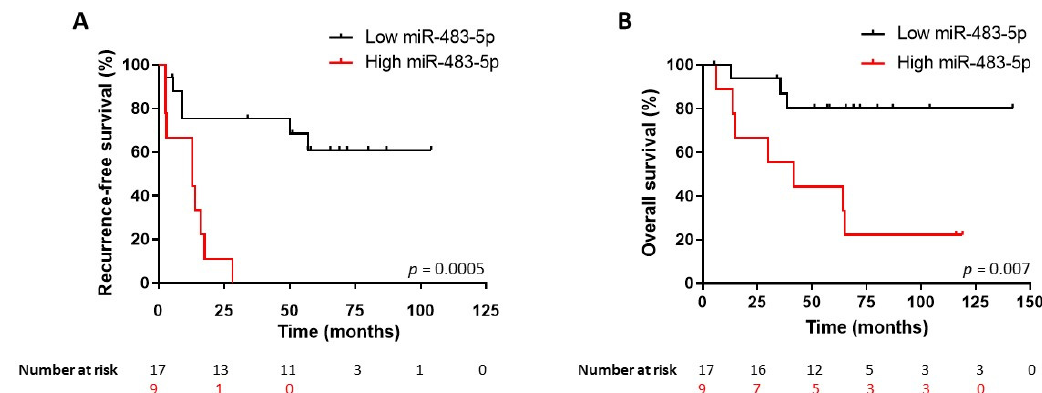
Figure 5. Kaplan–Meier survival analysis of all 26 patients (NR3yrs n = 11, R < 3yrs n = 13 and two patients with no recurrence and follow-up <3 years) according to miR-483-5p circulating levels. ( A ) Recurrence-free survival (RFS). High levels of miR-483-5p (>752,898 copies/mL cut-off value) within the 3-month post-surgery period predict a shorter RFS (Log-rank p = 0.0005). ( B ) Overall survival. High levels of miR-483-5p (>752,898 copies/mL cut-off value) within the 3-month post-surgery period predict a shorter OS (Log-rank p = 0.007).